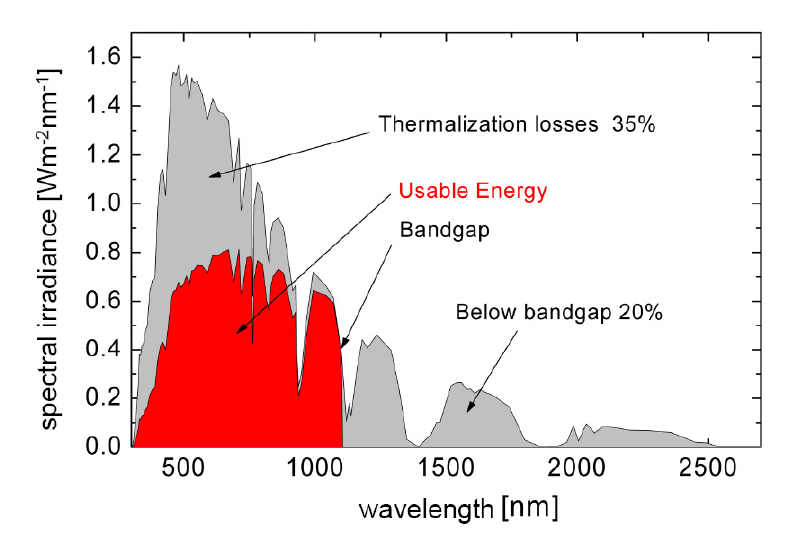
Figure 8. Illustration of the fundamental losses in a silicon solar cell, associated with the sub-band-gap (transparency) losses of low-energy photons and the thermalization losses of high-energy